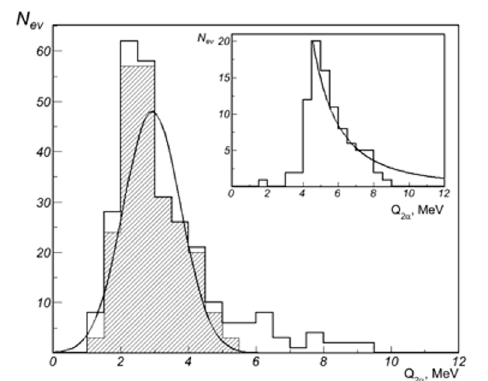
Figure 3. Distribution on energy Q 2 α of 278 pairs of α -particles; hatched histogram correspond to condition of selection of events L 1 and L 2 < 12.5 μ m, Θ > 145 0 ; line – Gaussian. On the insertion: Q 2 α distribution of additional 98 α -pairs having L 1 and L 2 >12.5 μ